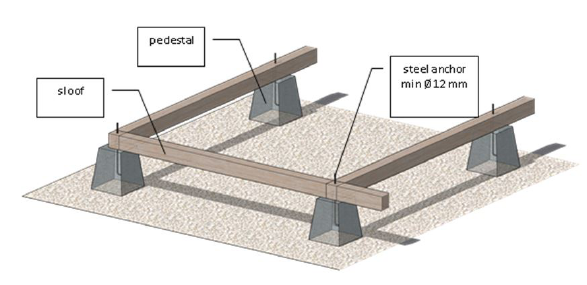
Fig. 1. Pedestal ( Umpak ) foundation principle Source: Pub- lic Works Department, 1993